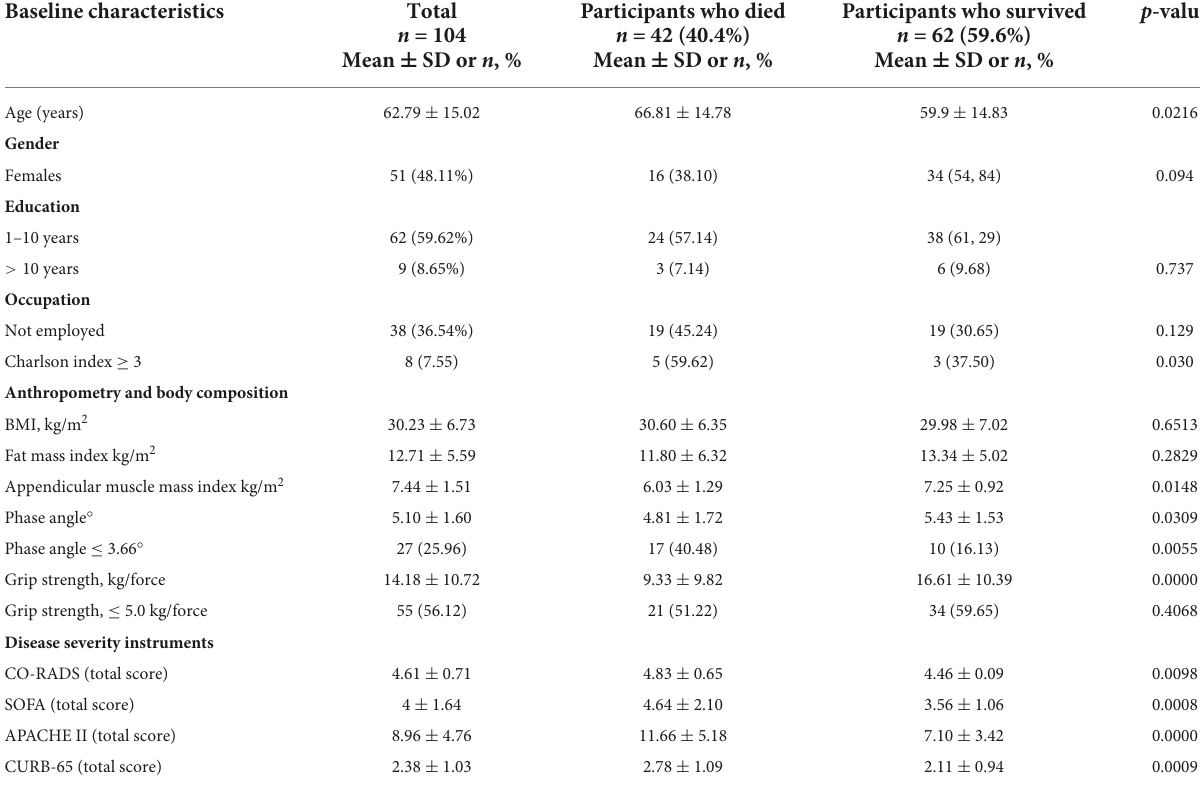
TABLE 1 Baseline characteristics: sociodemographic, clinical, anthropometry, and body composition and disease severity scales. Baseline characteristics